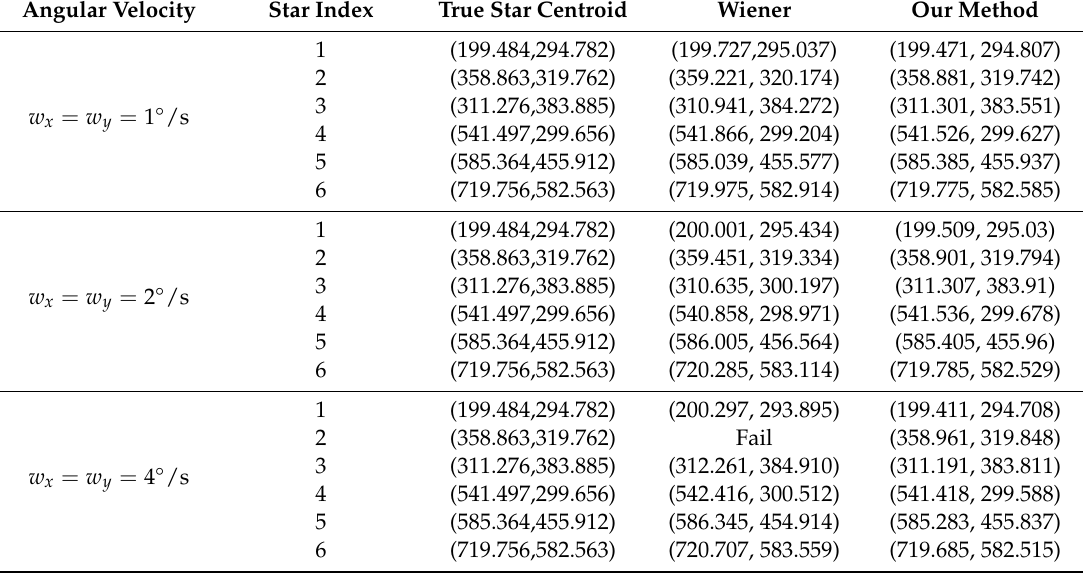
Figure 14. Star images of the Wiener filter under the dynamic condition of w x = w y = 4 ◦ /s. ( a ) Star image restored by Wiener filter and its three-dimensional distribution; ( b ) energy distribution of NO.1 star. Table 3. Star centroid coordinates under different angular velocities.